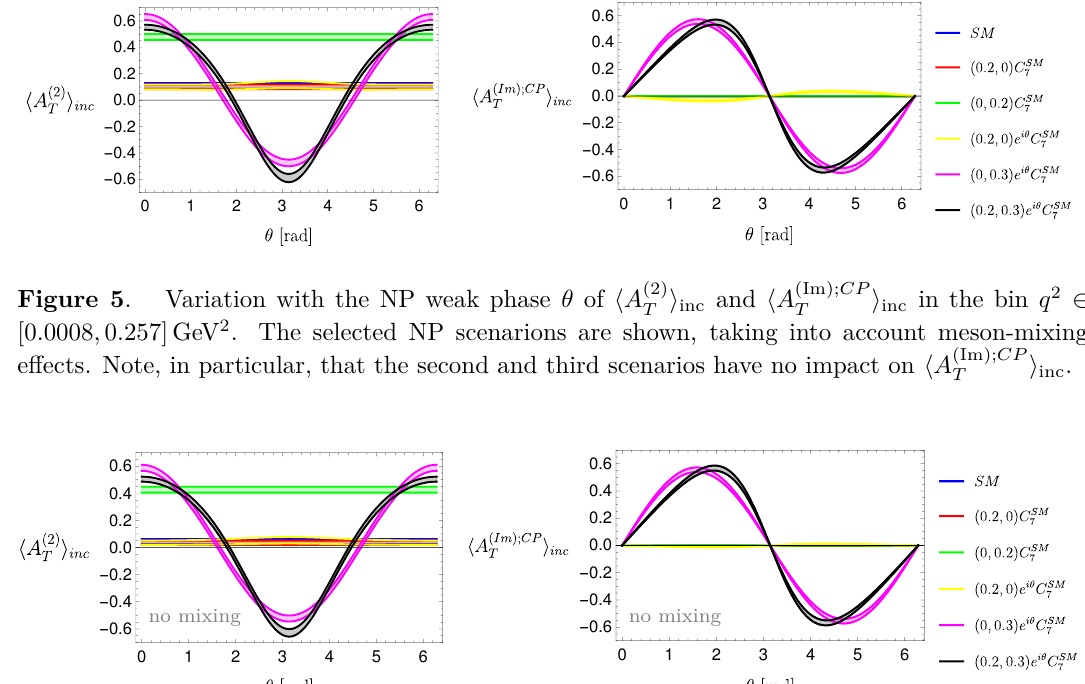
i inc and h A ( Im ); CP i inc in the bin q 2 ∈ T T